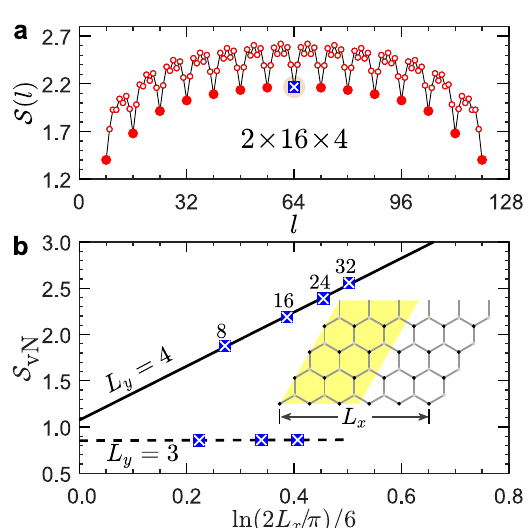
Fig. 7 Entanglement entropy scaling. a Entanglement entropy Sð l Þ of a consecutive segment of length l on a 2 × 16 × 4 cylinder in the Γ model. The solid symbols of the lowest branch represent the neat edge-cutting with l being a multiply of 8 (i.e., the number of the sites along each column). The bipartite entanglement entropy with l = N / 2 is marked as a blue square. b Entanglement entropy scaling on three-leg cylinders (dashed line) and four-leg cylinders (solid line). The fi tting constants are ð c ; c 0 Þ (cid:7) ð 0 : 02 ; 0 : 85 Þ and ð c ; c 0 Þ (cid:7) = 3 and 4, respectively. The inset shows the ð 2 : 92 ; 1 : 09 Þ for L y bipartite partition of a four-leg cylinder with equal sites in the left and right halves.